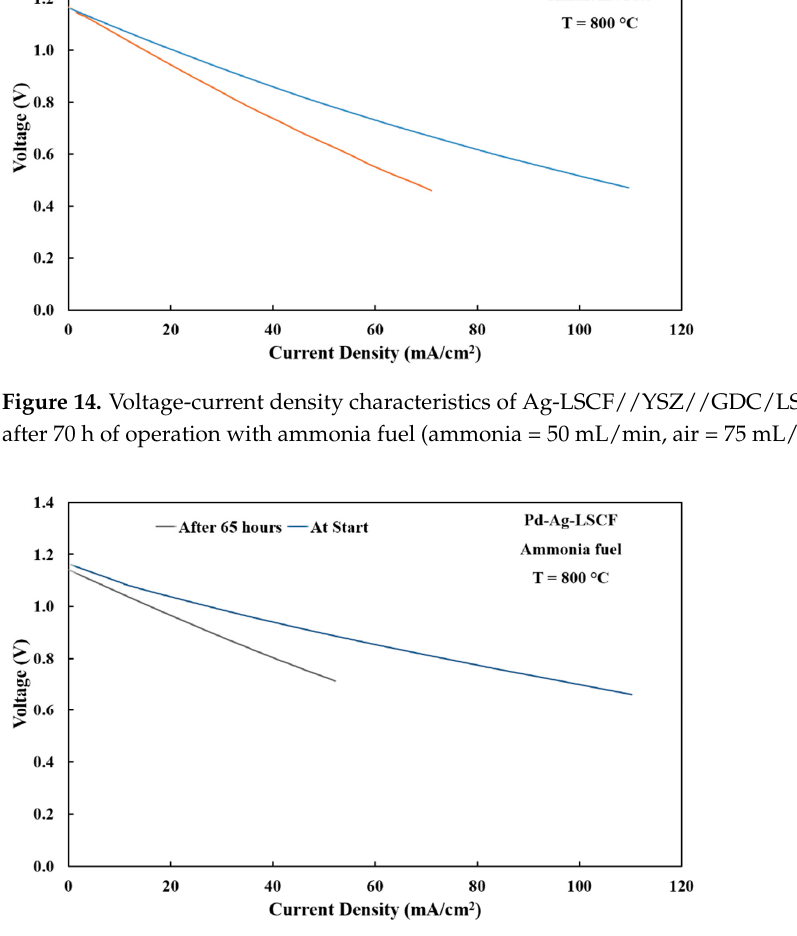
Figure 16. SEM image of Pd infiltrated Ag-LSCF anode surface after testing.